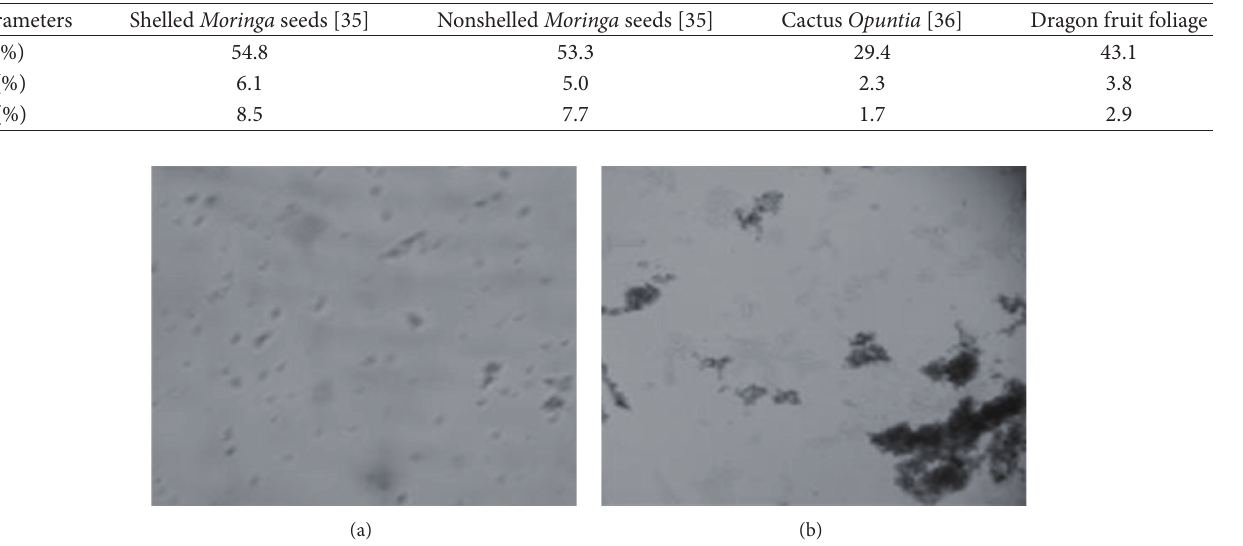
T 3: Elemental analysis of dragon fruit foliage and comparison with other natural coagulants.